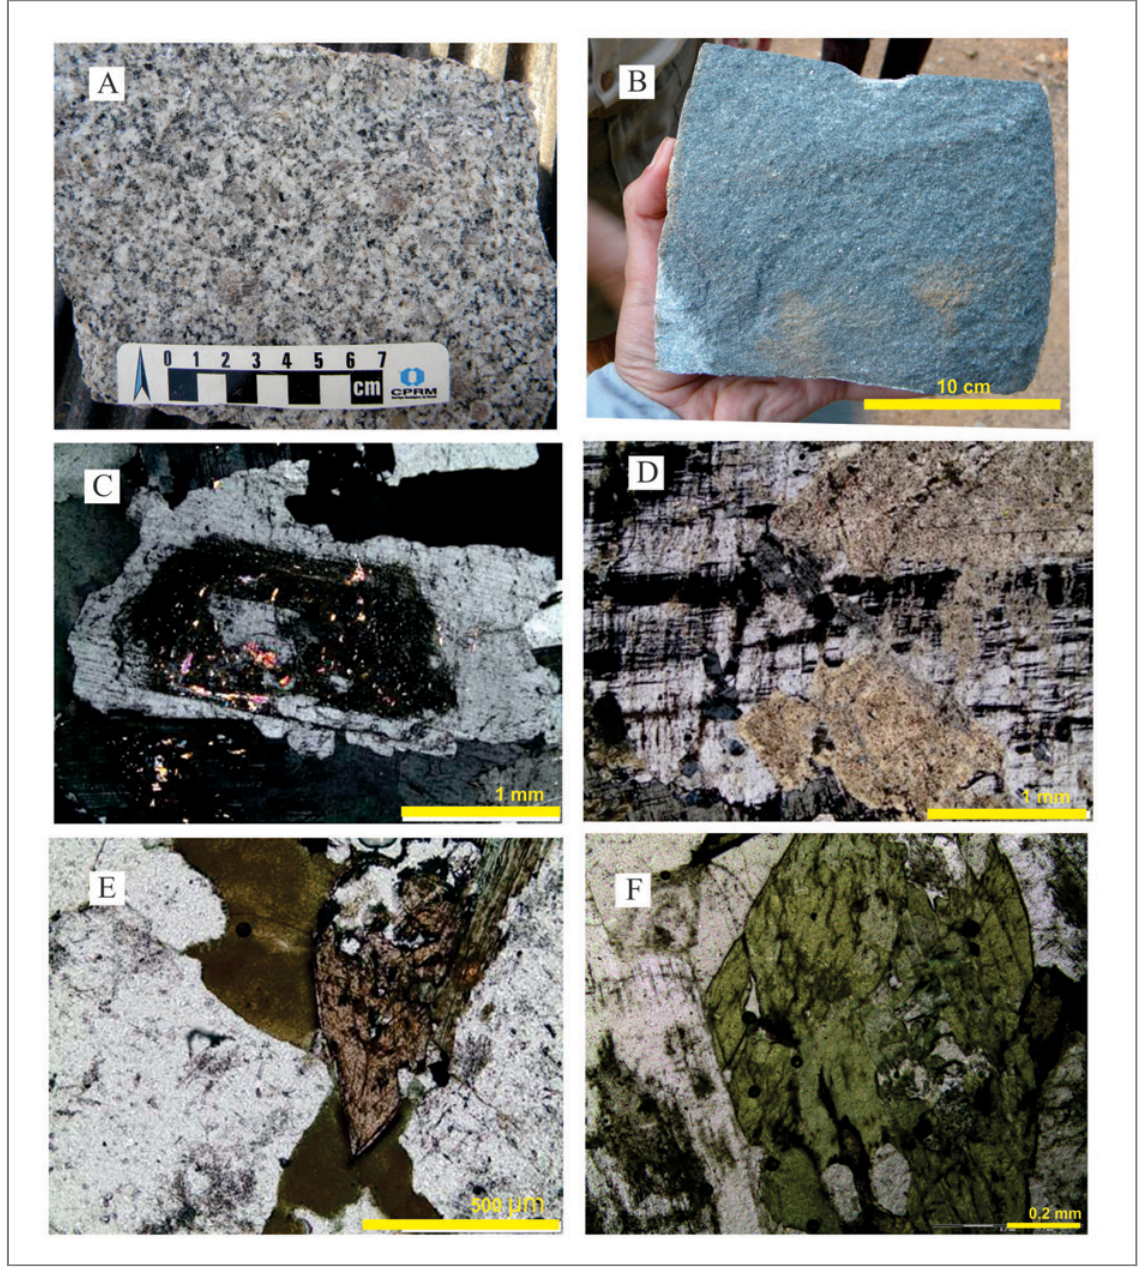
Figure 9 - Mesoscopic and microscopic aspects of the Creporizão Intrusive Suite (CIS). A) Gray equigranular monzogranite; B) hornblende granodiorite; C) zoned plagioclase phenocryst with epidote grains in the core; D) partially sericitized microcline phenocryst; E) titanite grain associated with chlorite lamella, adjacent to a brown biotite lamella F) hornblende phenocryst with inclusions of magnetite and